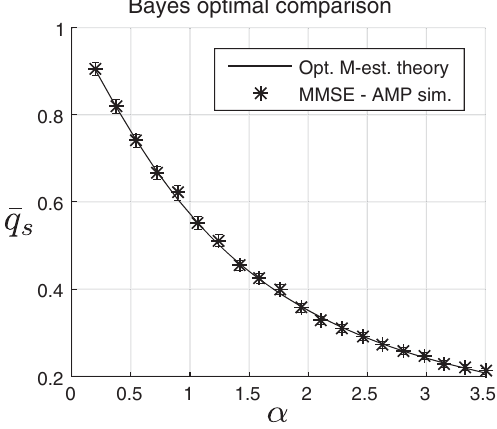
FIG. 7. A comparison between optimal M-estimation and Bayesian MMSE inference for the setting of Laplacian noise and signal ( E ϵ ¼ j ϵ j , E s ¼ j s 0 j , as also used in Fig. 6). We compare the normalized MSE, or fraction of unexplained variance ¯ q s predicted by our theory of optimal regularized M-estimation (solid line), with simulations (error bars) of Bayes-optimal approximate message passing [37]. For our simulations, we randomly generated finite-size data (with N ffiffiffiffiffiffiffi p NP and P varying while N ¼ α P and ¼ 250 ), and the error bars reflect standard deviations of message-passing performance calculated over 100 trials. We find an excellent match between optimal M-estimation theory and Bayesian AMP